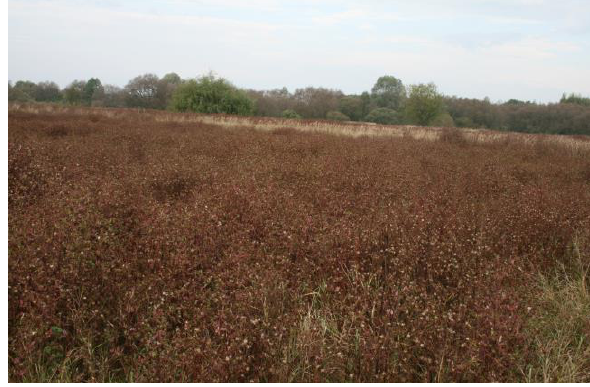
Fig. 6. Bidens frondosa L. in the floodplain of the River Dnieper in Belarus